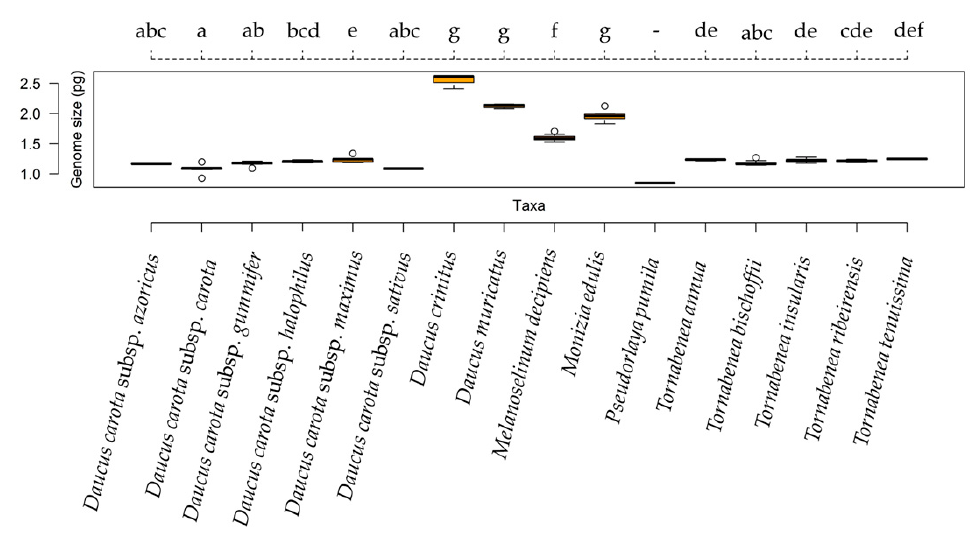
Figure 3. Boxplot diagram showing the genome size variation across the 16 taxa from the Daucinae subtribe. The orange